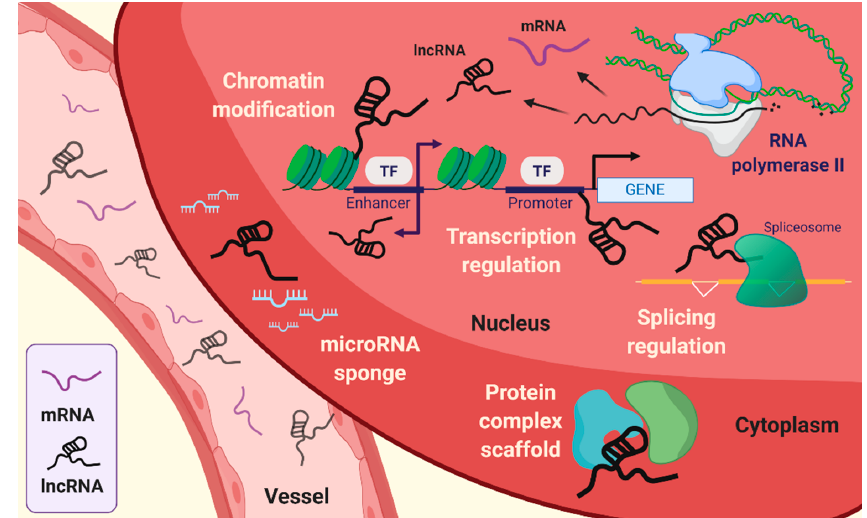
Figure 1. Emerging roles of long non-coding RNAs (lncRNAs). lncRNAs are associated with intracellular Figure1. Emergingrolesoflongnon-codingRNAs(lncRNAs).